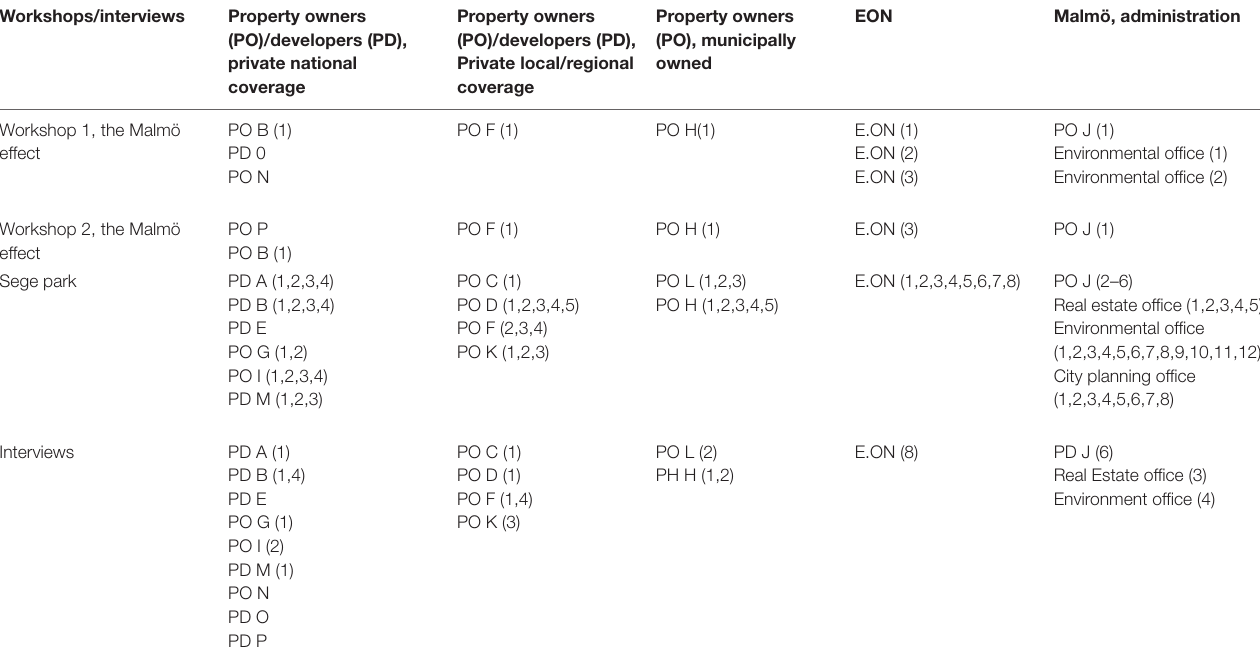
TABLE 2 | Actors participated during the workshops, the dialogue meetings, and the interviews, divided according to the organizations they represented.